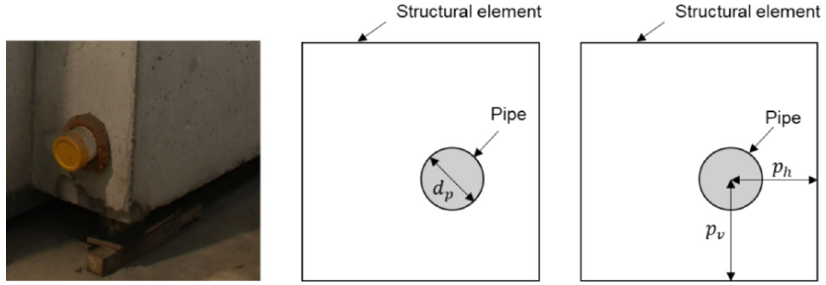
Figure 9. Measurement of the dimension ( 𝑑 (cid:3043) ) and position ( 𝑝 (cid:3035) and 𝑝 (cid:3049) ) of a cylindrical pipe